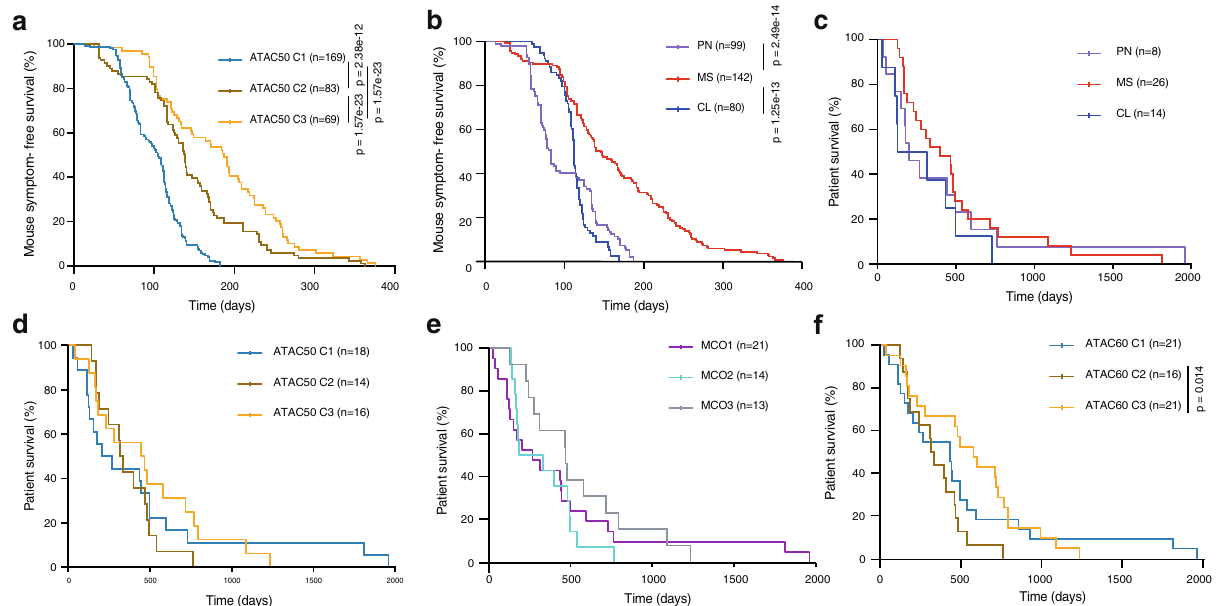
Fig. 6 Survival analyses comparing ATAC50, TCGA subtype, MCO, and ATAC60 classi fi cations. a , b Kaplan – Meier analysis of symptom-free survival of immune-de fi cient mice intracranially injected with 10 4 , 10 5 , or 2 × 10 5 cells from 35 different hGSC cultures. n , number of injected mice. a Cultures are divided by ATAC50 clusters, C1 ( n = 14), C2 ( n = 11), C3 ( n = 9). b Cultures are divided by TCGA subtypes, PN ( n = 6), MS ( n = 21), CL ( n = 7). c – f Kaplan – Meier analysis of GBM patient survival. n , number of patients. c Patients are divided based on TCGA subtype. d Patients are divided based on ATAC50. e Patients are divided based on MCO. f Patients are divided based on ATAC60 clusters. C2 versus C3. Log-rank (Mantel – Cox) test was used and signi fi cant differences are indicated with p values. Source data are provided as a Source Data fi le for Fig. 6a –